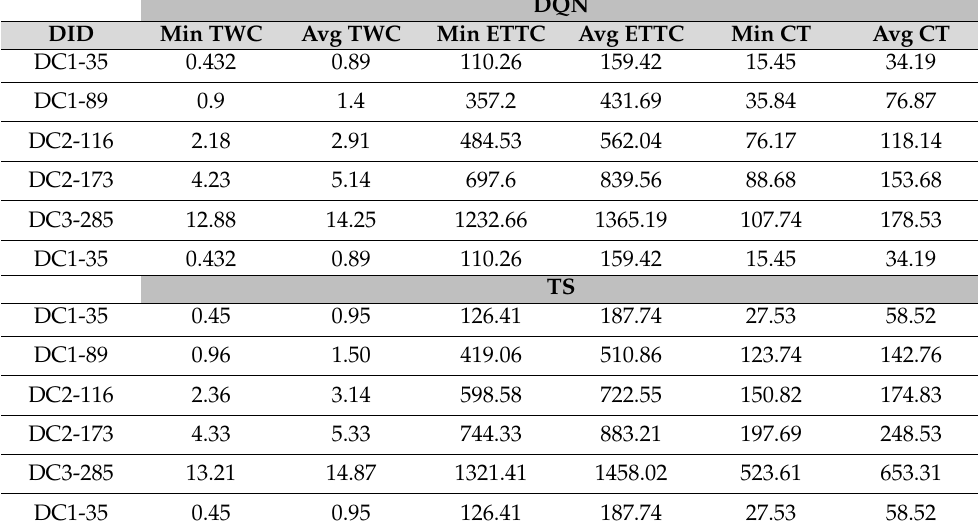
Table 10. Performance comparison between DQN and